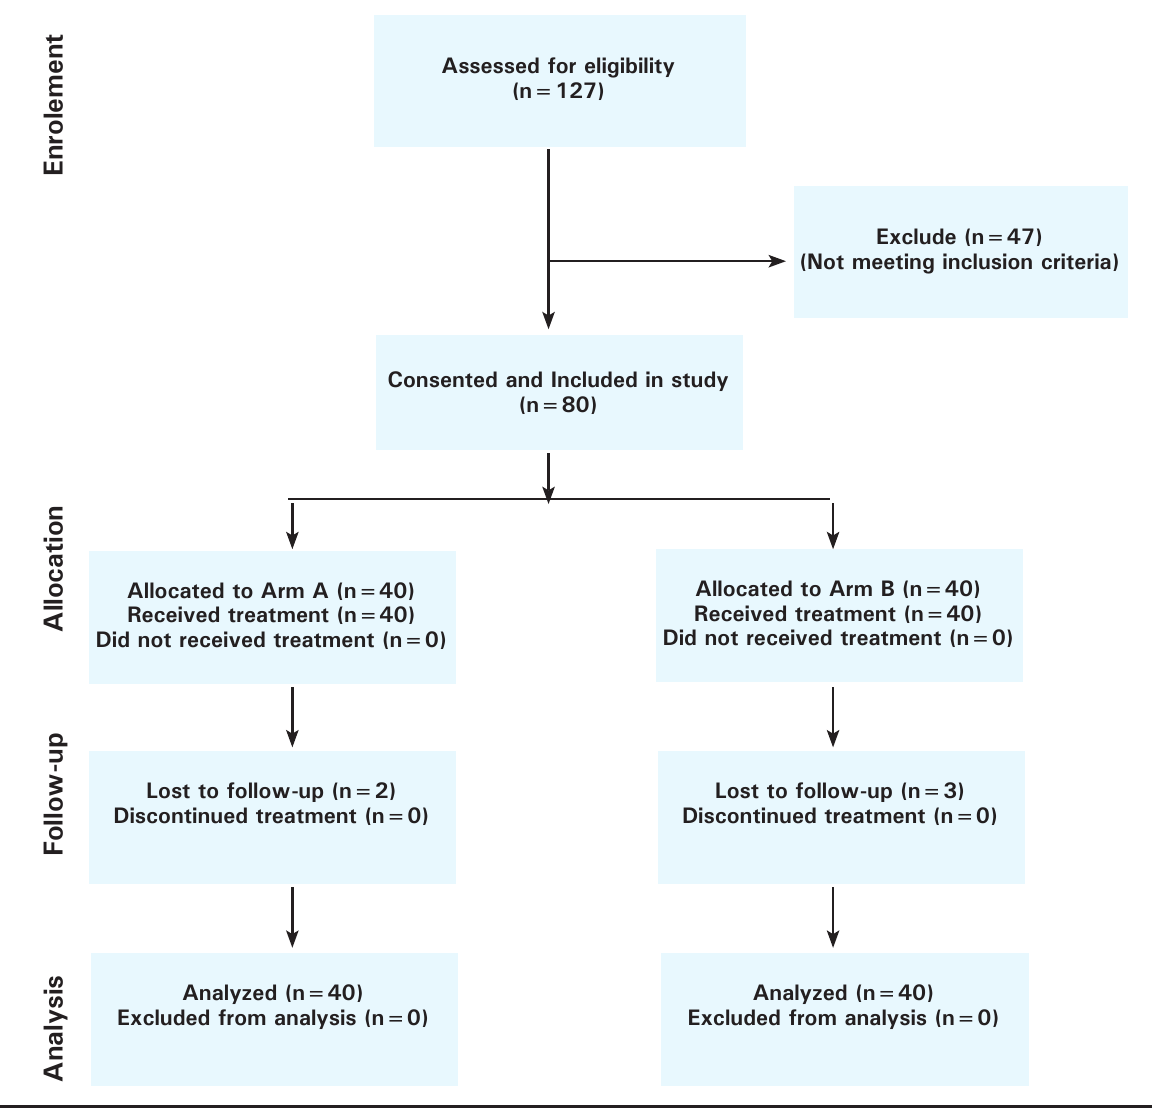
Figure 1. Showing consort flow chart of patients enrolled in the